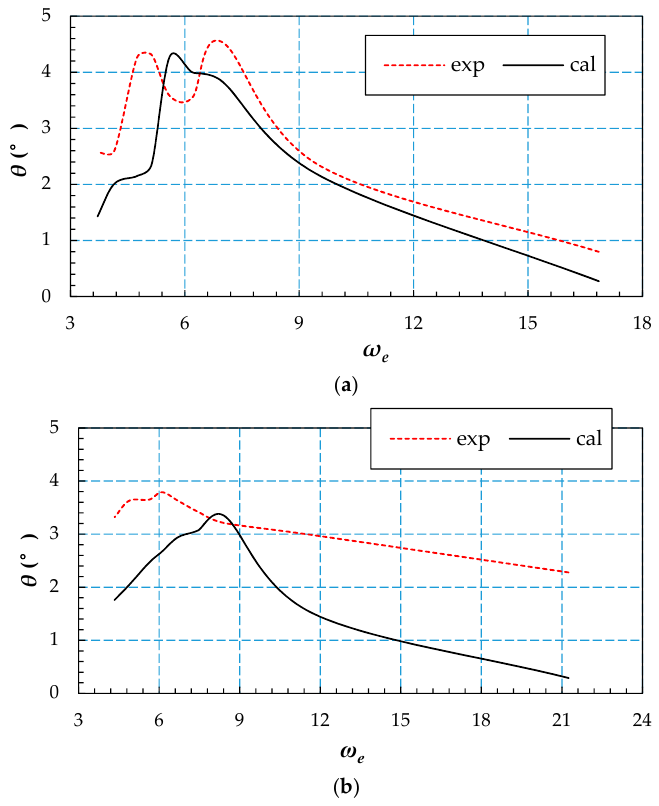
Figure 26. The contrast curves of pitch response of ( a ) F n = 0.71 and ( b ) F n = 0.99. Water 2019 , 11 , x FOR PEER REVIEW